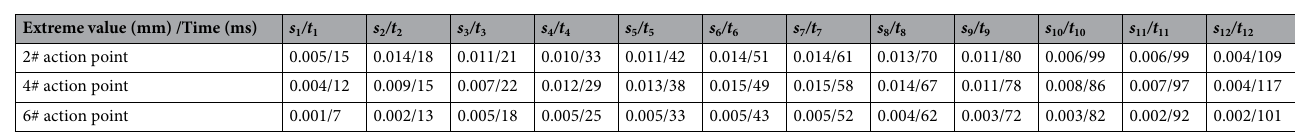
Table 6. The extreme points of amplitude curves of 2#, 4# and 6# action points.